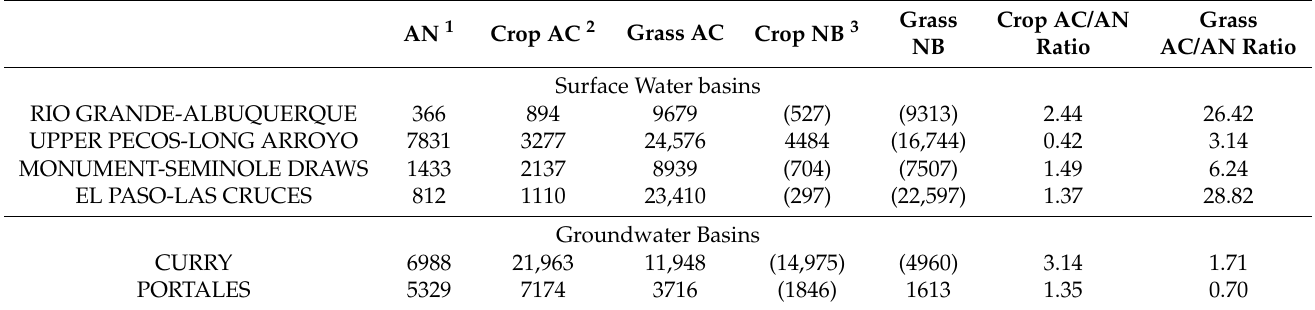
Table 3. Watershed-level nitrogen balance assessment (in thousand